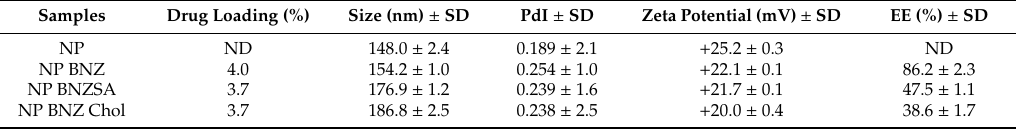
Table 1. Physicochemical properties of drug-free NPs, drug-loaded NPs (NP BNZ), and functionalized NP BNZ formulations.